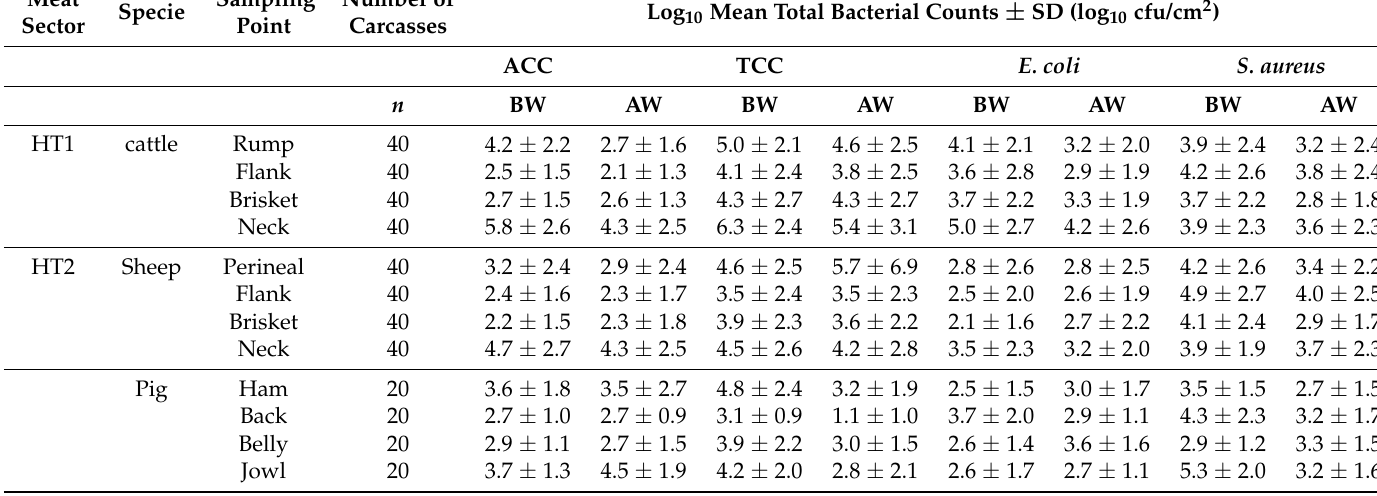
Table 2. The logarithm 10 of mean total bacterial counts for cattle meat samples from selected abattoirs in the Eastern Cape Province, South